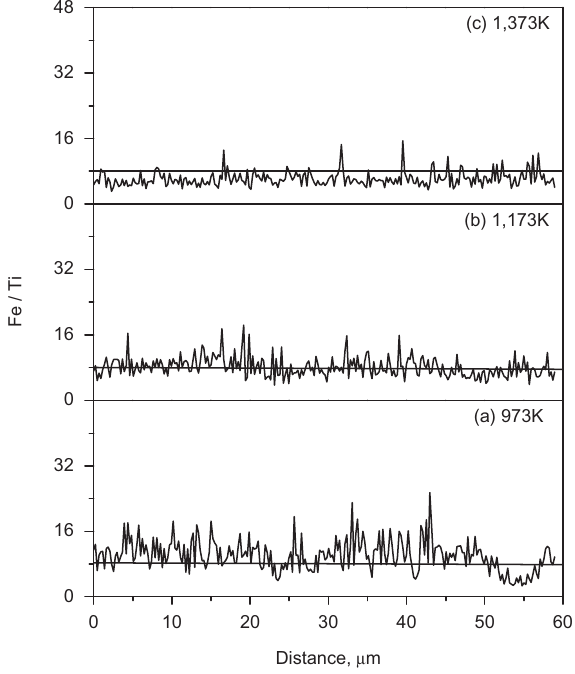
Figure 8: The Fe/Ti ratio of the white phase in HCVTM oxidized pellet at 973 K (a), 1,173 K (b), and 1,373 K (c).